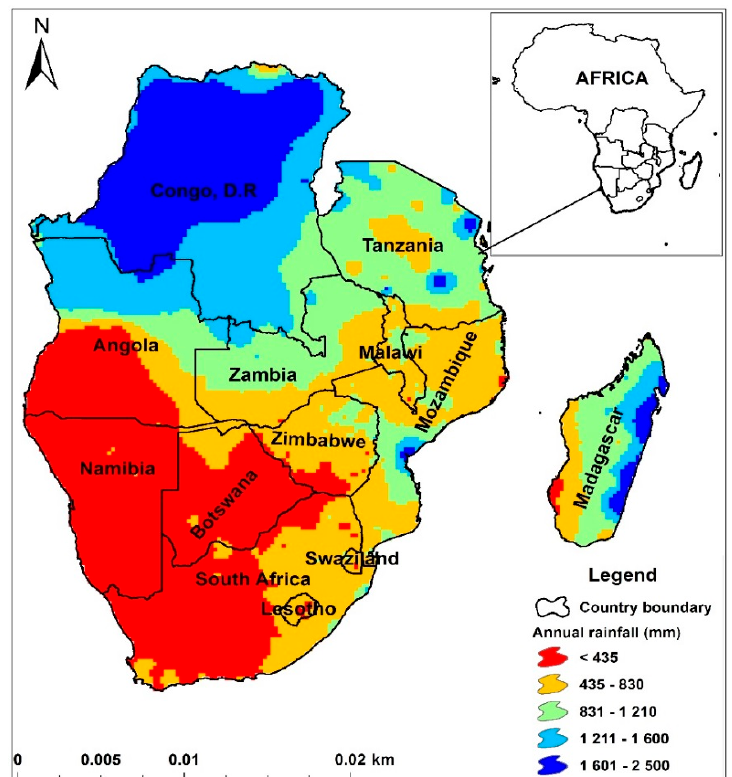
Figure 1. Locational map of Southern African Development Community (SADC) countries in Africa also showing annual rainfall distribution. Source: Developed by authors.